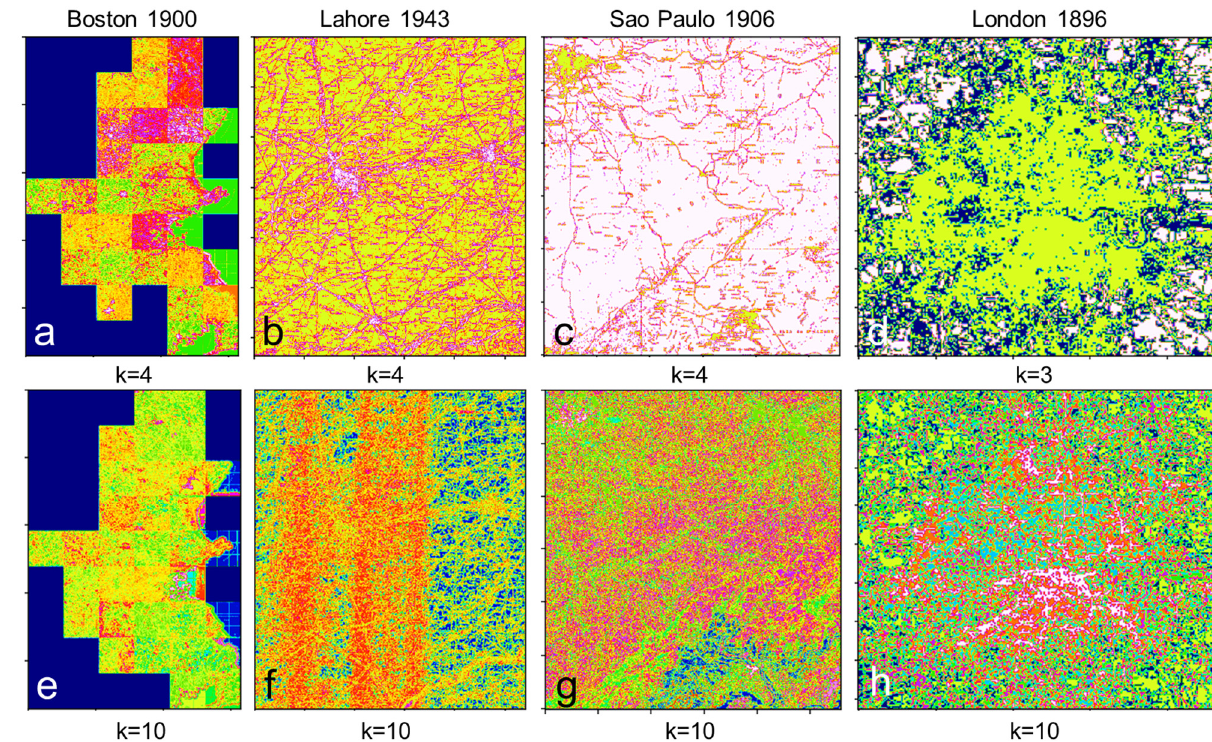
Figure 8. Raw color-space clustering results illustrating the effect of the number of clusters k on the spatial and semantic output granularity shown for a low k for the ( a ) Boston, ( b ) Lahore, ( c ) Sao Paulo, and ( d ) London study areas, and for a high k in ( e – h ).